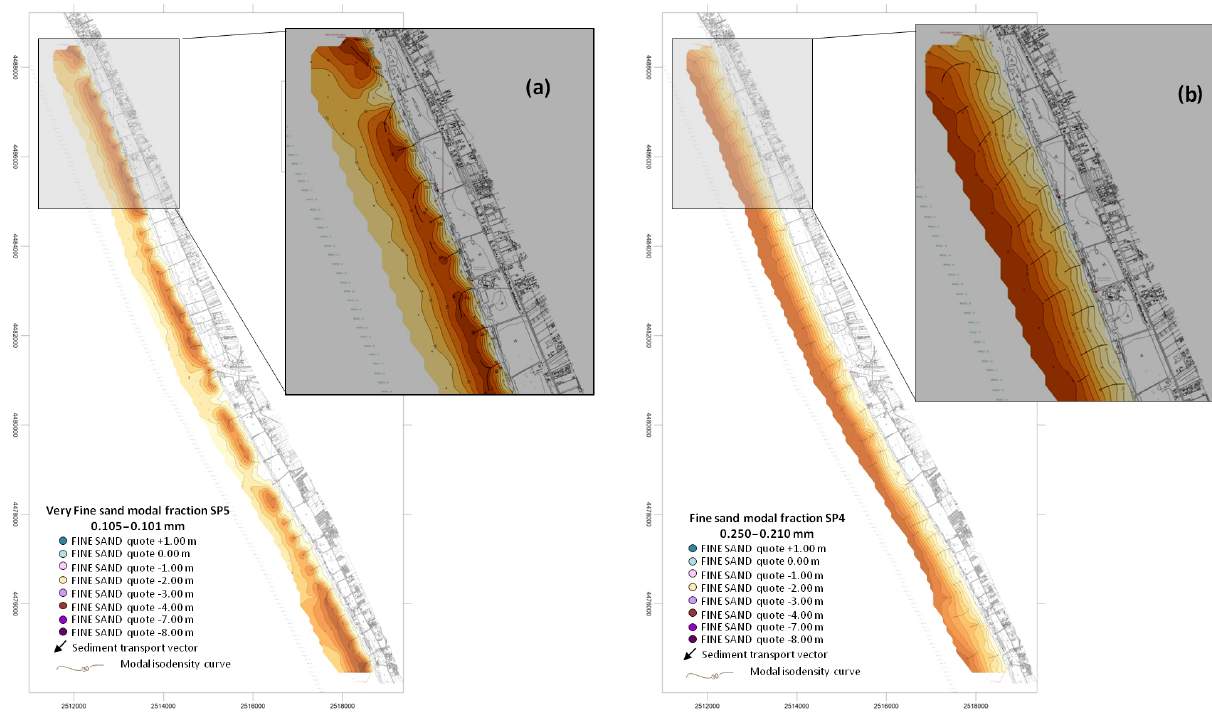
Figure 5. Sediment transport vectors for the whole area referred to the modal subpopulation SP5 – very fine sand (a) – and SP4 – fine sand (b)